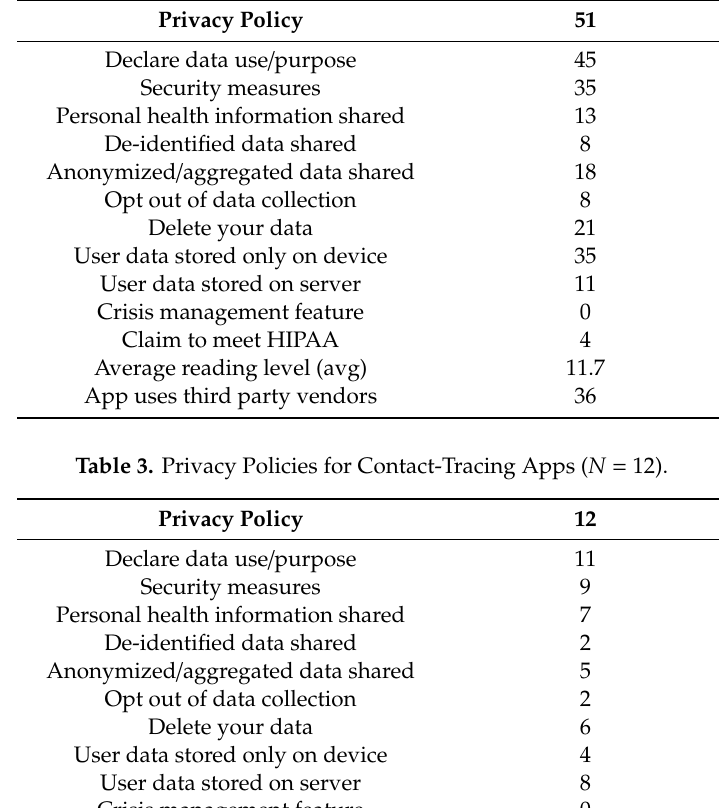
Table 2. Privacy Policies for Non-Contact-Tracing Apps ( N = 65). HIPAA, Health Insurance Portability and Accountability Act.